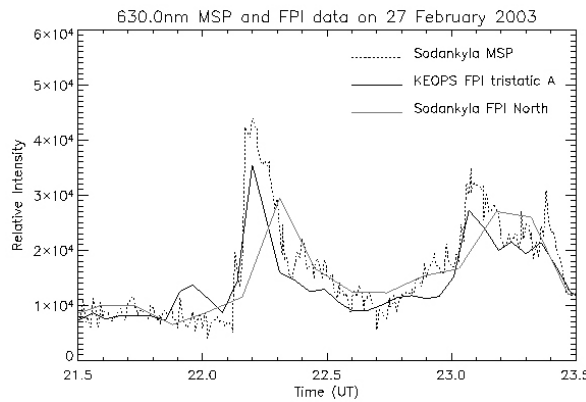
Fig. 14. Investigation of the 630-nm emission height by compari- son of features seen by the Sodankyl¨a MSP with the KEOPS and Sodankyl¨a FPIs on the night of 27–28 February